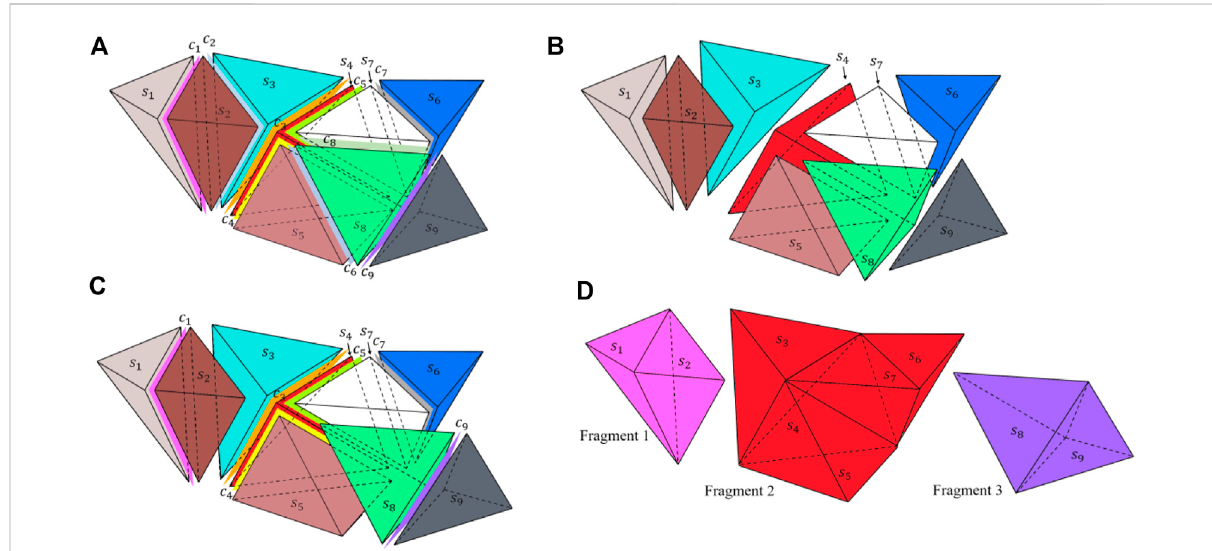
FIGURE 1 Schematic diagram of the fragment search algorithm: (A) the original connection state of elements; (B) generation of solid element pool; (C) search of the solid element by the unremoved cohesive elements; (D) recognition and generation of the fragment.